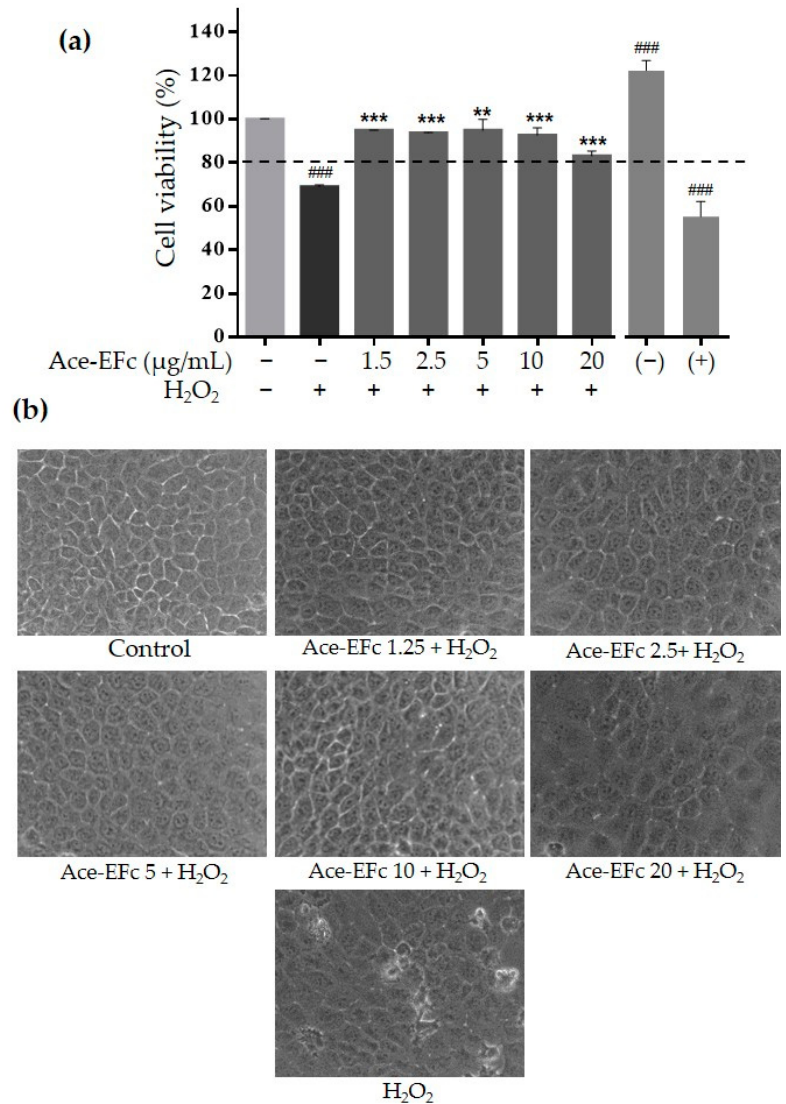
Figure 4. Protective effect of Ace-EFc against H 2 O 2 -induced cytotoxicity. HaCaT cells were pretreated Figure 4 with Ace-EFc (1.25, 2.5, 5, 10, and 20 µ g/mL) for 24 h before treatment with 1000 µ M H 2 O 2 for 2 h. ( a ) MTT assays. ( − ): negative control, cells stimulated with 10% FBS. (+). Positive control, 100 µ M Ara-C (cytarabine). Results were expressed as the mean ± SD of three independent experiments. One-way ANOVA, Dunnett’s test: ### p < 0.001 versus no treated cells; ** p < 0.01, *** p < 0.001 versus treated cells with H 2 O 2 . ( b ) Micrographs of HaCaT cells from ( a